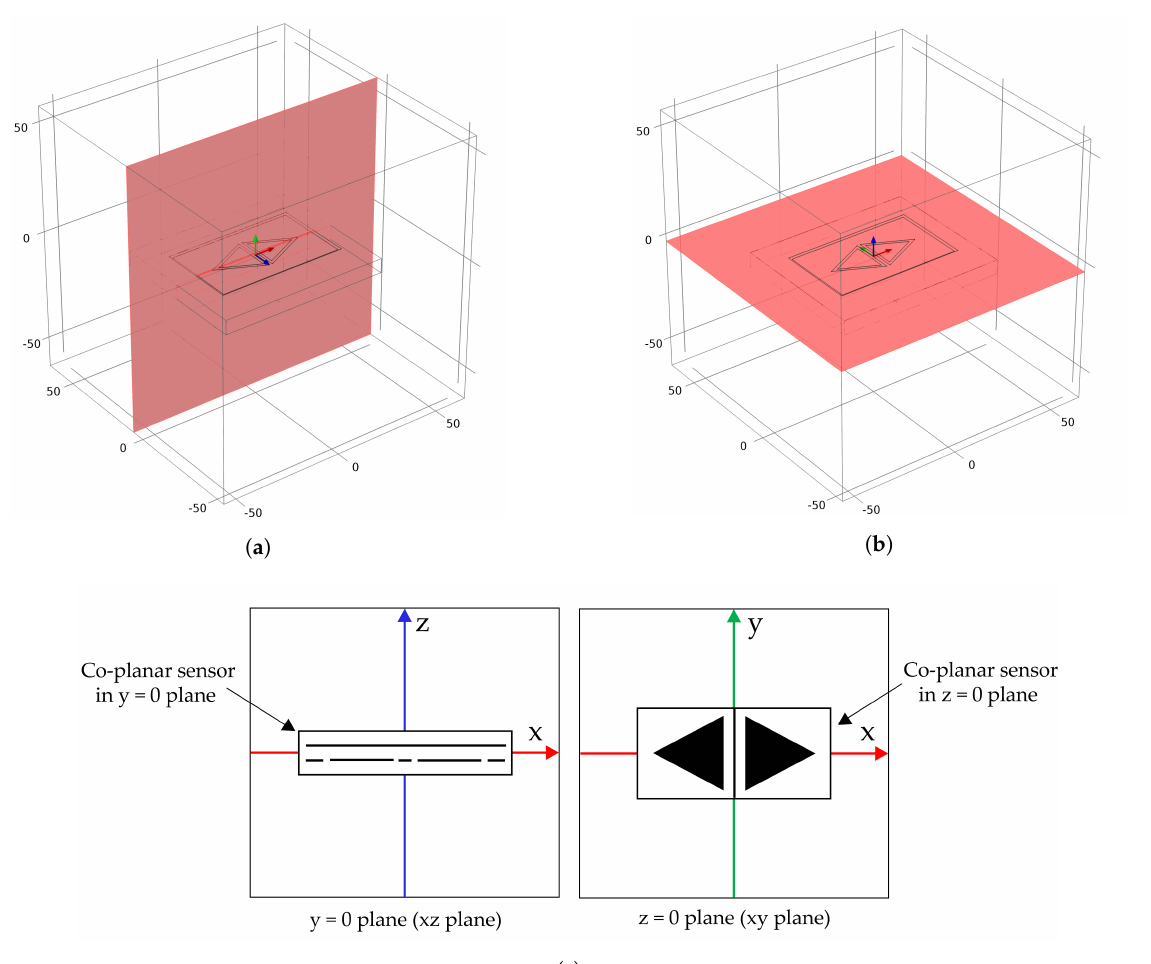
Figure 5. The cross-sectional plane along the long axis of symmetry of the capacitive probe: ( a ) y = 0 plane ( xz plane), ( b ) z = 0 plane ( xy plane), and ( c ) plane coordinate systems for the two kinds of cross